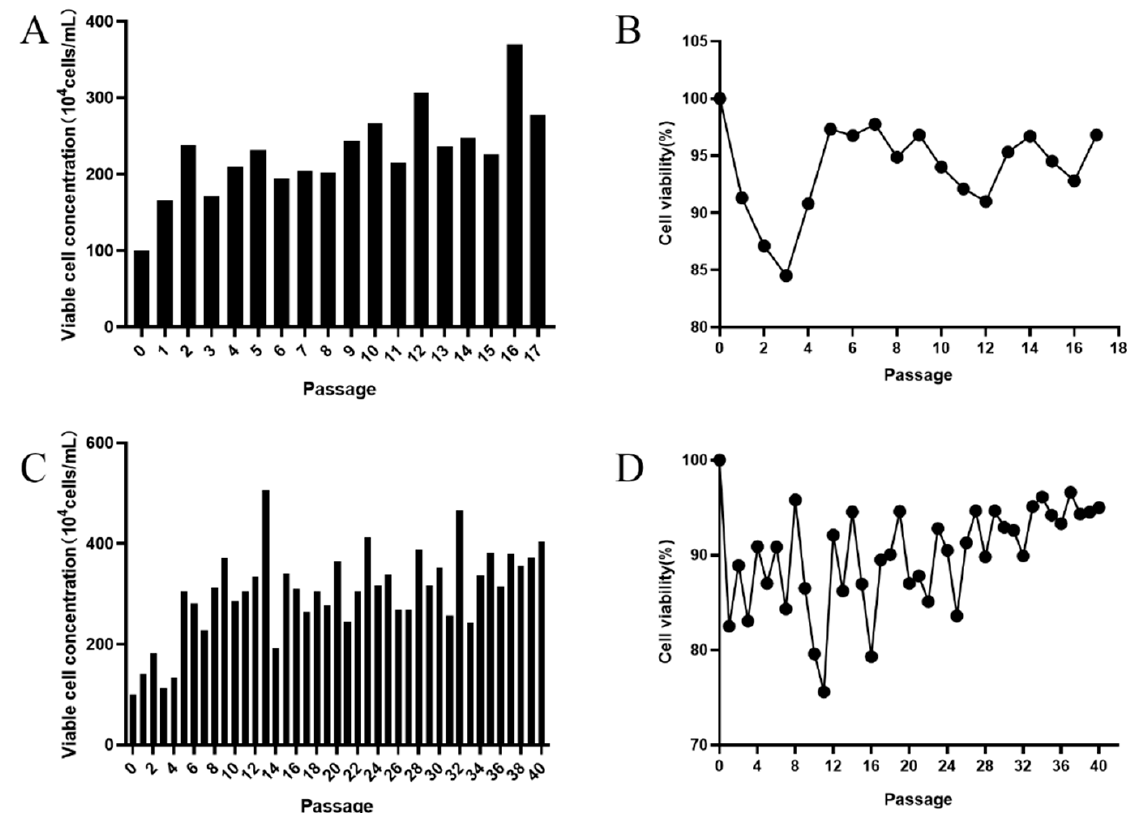
Figure 2. Adaptation of MDBK cells to suspension culture in serum-free medium. The adaptive growth ( A ) and viability ( B ) of adherent MDBK cells in shake flasks with ST503 containing 3% FBS. The adaptive growth ( C ) and viability ( D ) of suspension-adapted MDBK cells in shake flasks with ST503 only.